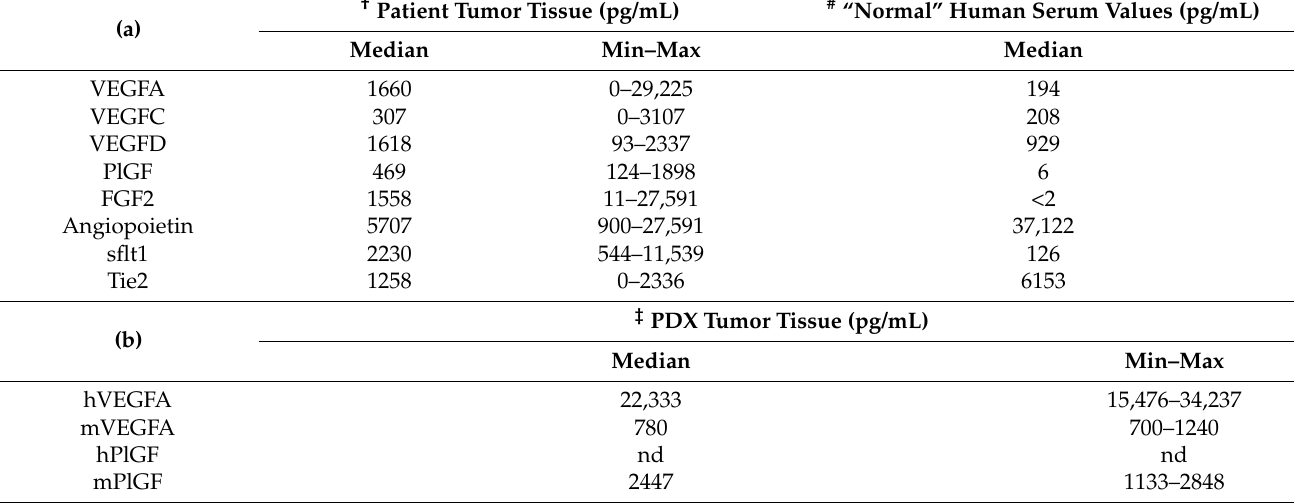
Table 2. Pro-angiogenic factors in tumor samples from pseudomyxoma peritonei (PMP) patients (2a) and the patient-derived xenograft (PDX) models